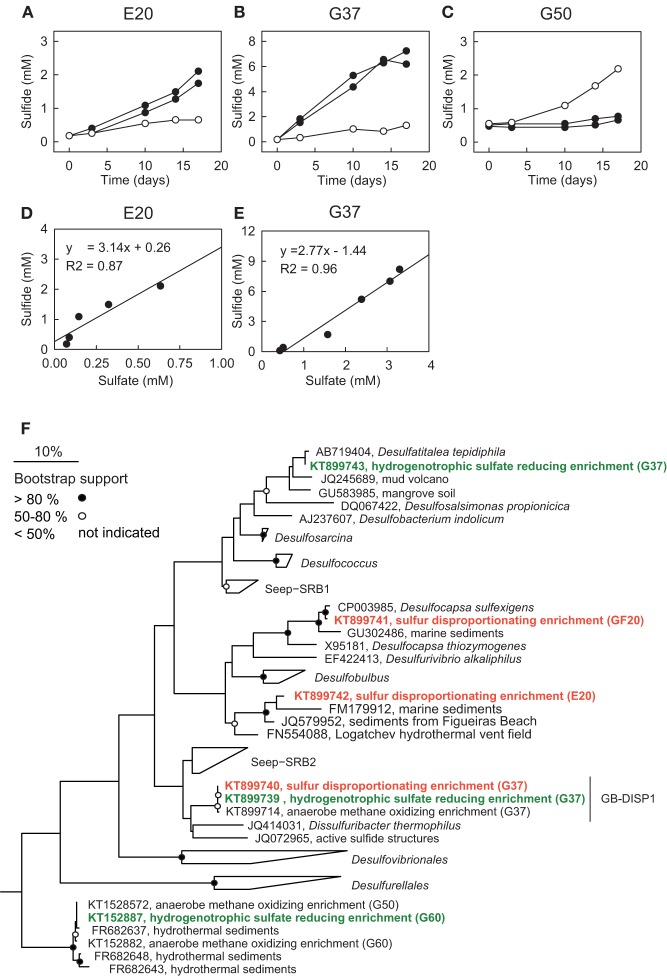
Sulfur disproportionation and sulfate reduction in AOM enrichment cultures. (A–C) Comparison of developments of sulfide concentrations in the three AOM enrichments under AOM conditions [methane (0.2 MPa) plus sulfate (20 mM; open circles)] and during addition of colloidal sulfur (20 mM; filled circles; two replicates) within 18 days. (D,E) Comparison of sulfide and sulfate production in zero-valent sulfur amendments of E20 and G37; disproportionation has not been observed in G50. The observed approximate 3:1 stoichiometry between sulfide and sulfate production is characteristic for disproportionation of elemental (zero-valent) sulfur. (F) Phylogenetic affiliation of sulfur-disproportionating (red) and sulfate-reducing (green) bacteria within the Deltaproteobacteria based on nearly full-length 16S rRNA sequences retrieved from high dilutions of AOM-active cultures supplied with elemental sulfur.